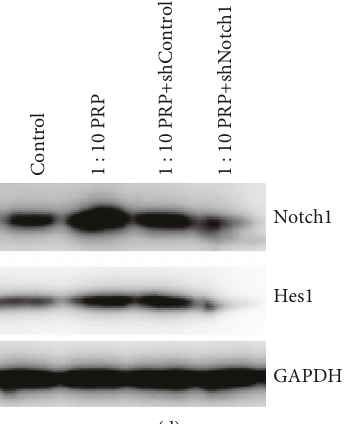
Figure 2: qPCR and western blotting results of angiogenic and Notch 1 pathway-related genes in EPC. There were signi fi cant di ff erences between the control and treatment groups. In addition, the 1 :10 PRP groups had several genes that were signi fi cantly upregulated compared with those in the other groups. (a and c) Gene expression changes by qPCR. (b and d) Protein expression levels by western blotting. ∗ p < 0 05 for the treatment groups vs. the control group and for the shNotch group vs. the other groups, § p < 0 05 for the 1 :10 PRP group vs. the 1:20 PRP group, and # p < 0 05 for the 1 :10 PRP group vs. the 1:5 PRP